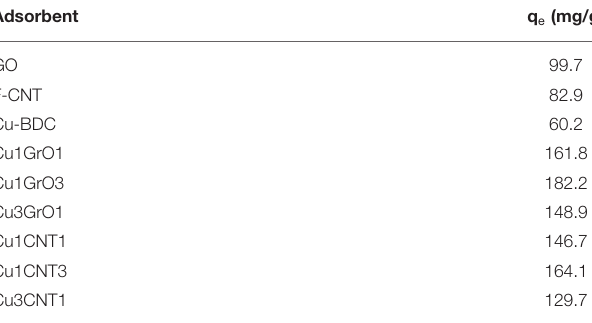
TABLE 5 | Bisphenol A (BPA) adsorption capacities of various hybrid nanocomposites.